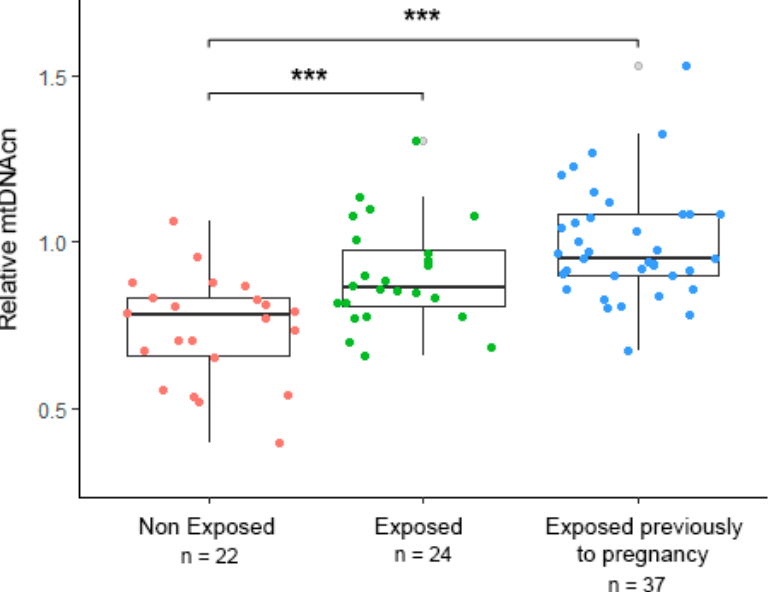
Figure 1. Umbilical cord blood mitochondrial DNA copy number (mtDNAcn) in infants born before the earthquake (non-exposed, n = 22, red circles), who were in gestation when the earthquake happened (exposed during pregnancy, n = 24, green circles), and who were conceived after the earthquake (exposed after pregnancy, n = 37, blue circles). Statistical differences were p < 0.05 (* = p < 0.05, ** = p < 0.01, *** = p < 0.001).